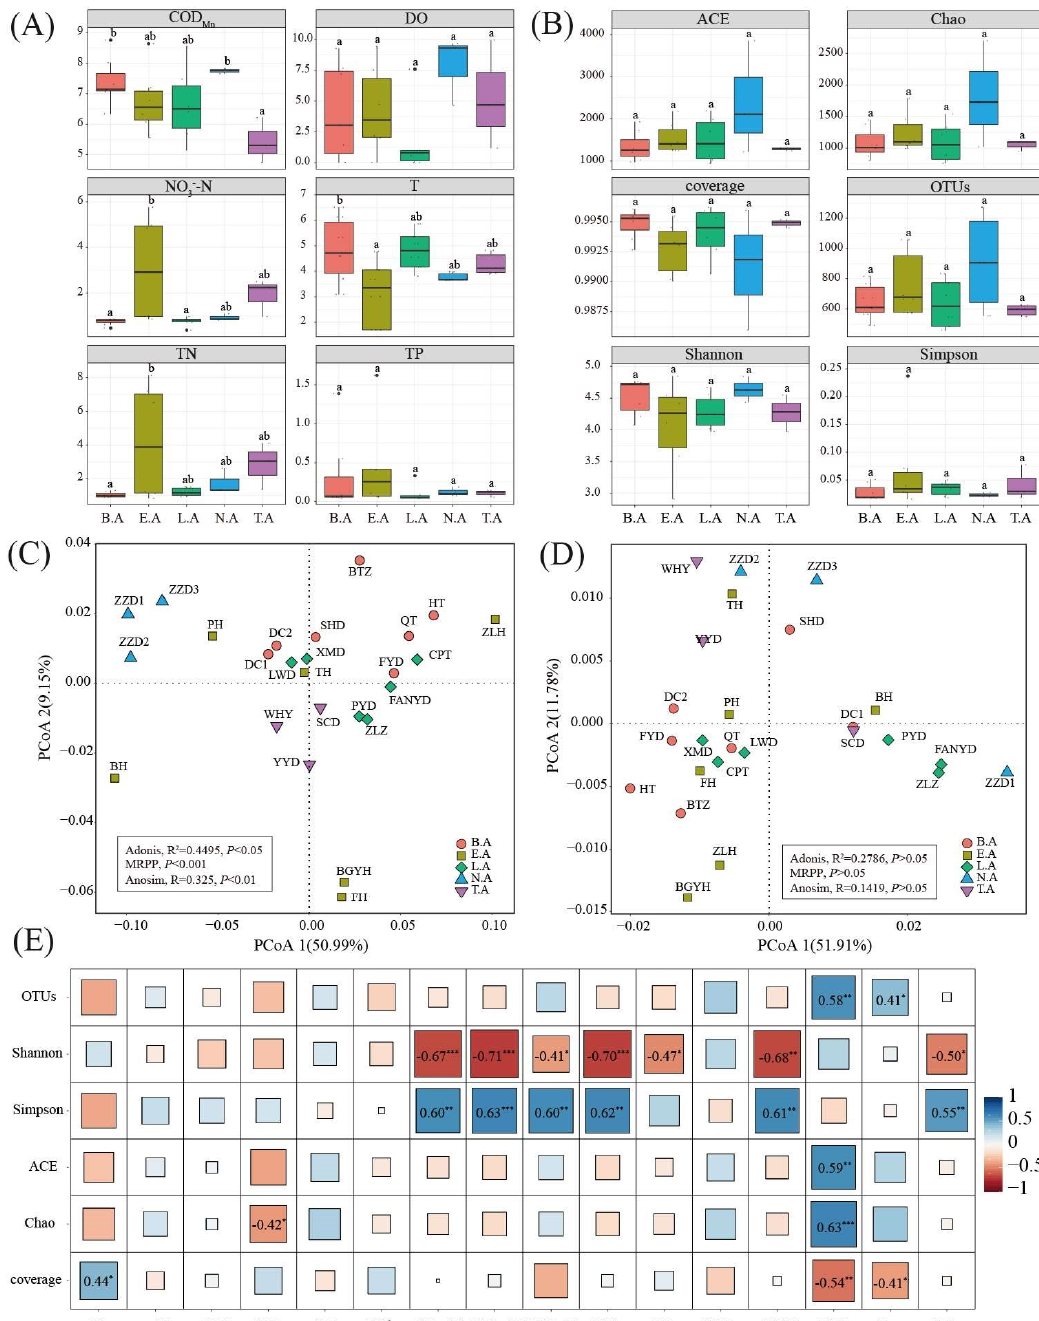
Figure 2. Alpha diversity and environment factors in Baiyangdian Lake. ( A ) environment factors (di ff erent letters are significantly di ff erent ( p < 0.05)); ( B ), Alpha diversity (di ff erent letters are significantly di ff erent ( p < 0.05)); ( C ), PCoA of alpha diversity; ( D ), PCoA of environment factors; ( E ) correlation between environment factors and alpha diversity (*, **, *** indicate the significance of the correlation at p < 0.05, p < 0.01, and p < 0.001).